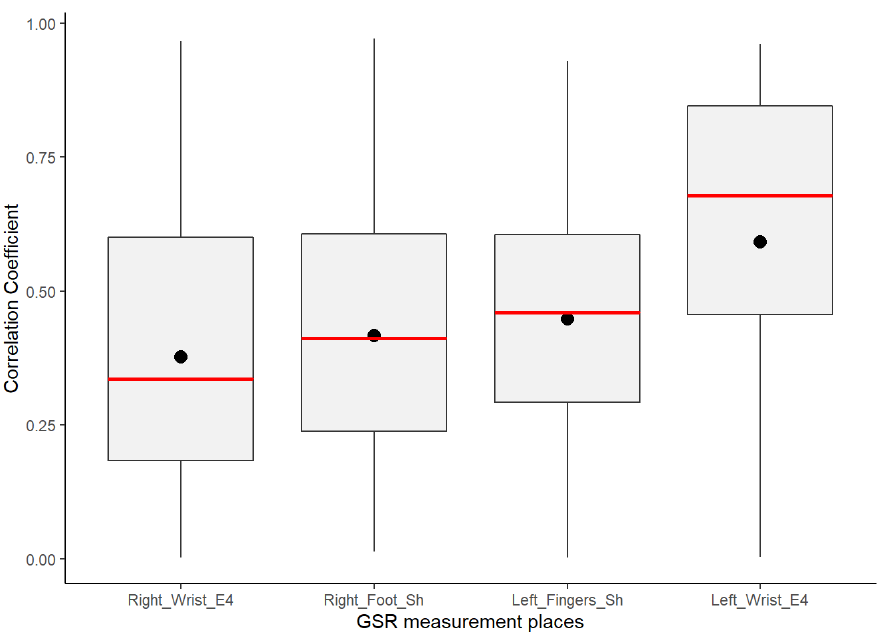
Figure 6. Box plot distributions of the positive coefficient correlations from the correlation matrices of each GSR signal.